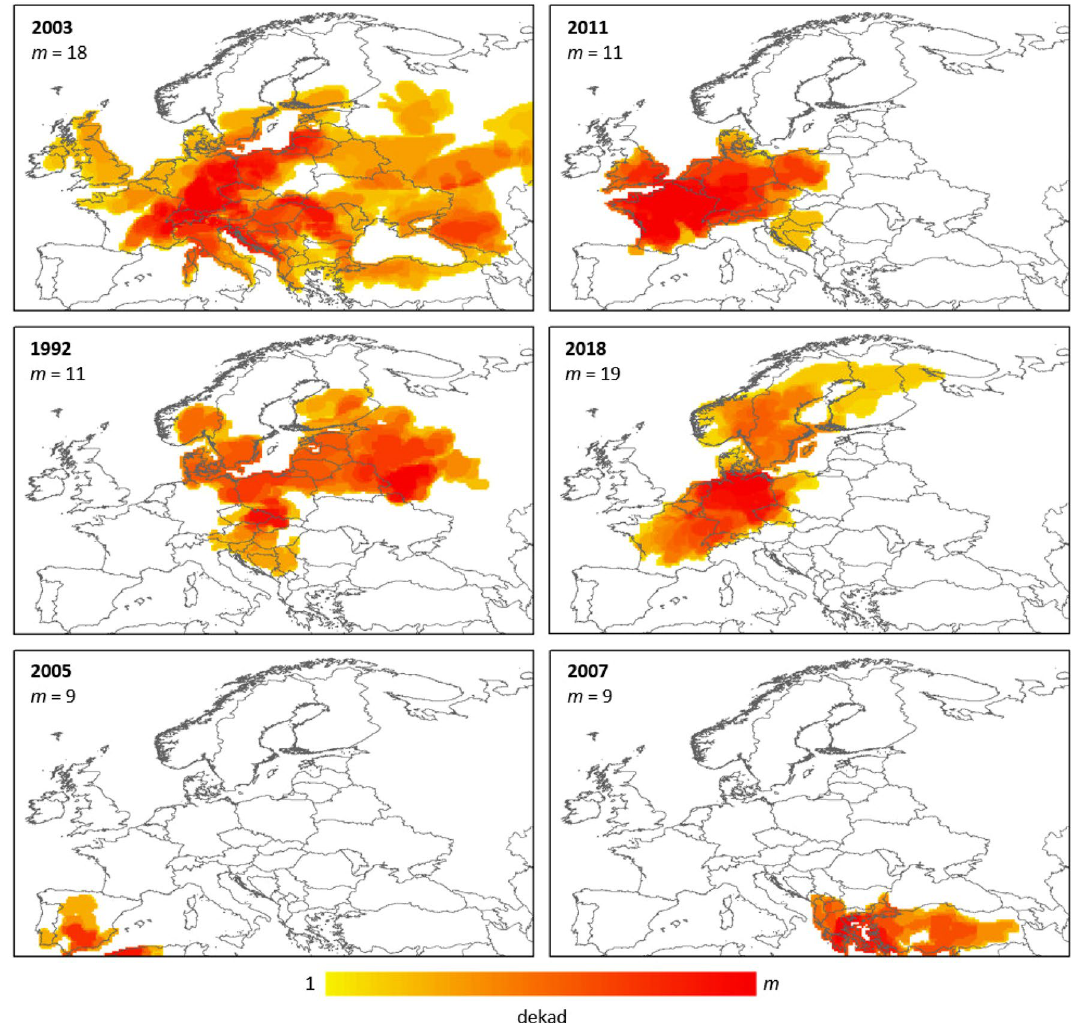
Figure 4. Heat-maps of some relevant droughts documented in the scientific literature and the EDII impact database. The maps represent the duration of the drought for each cell, obtained by summing along the